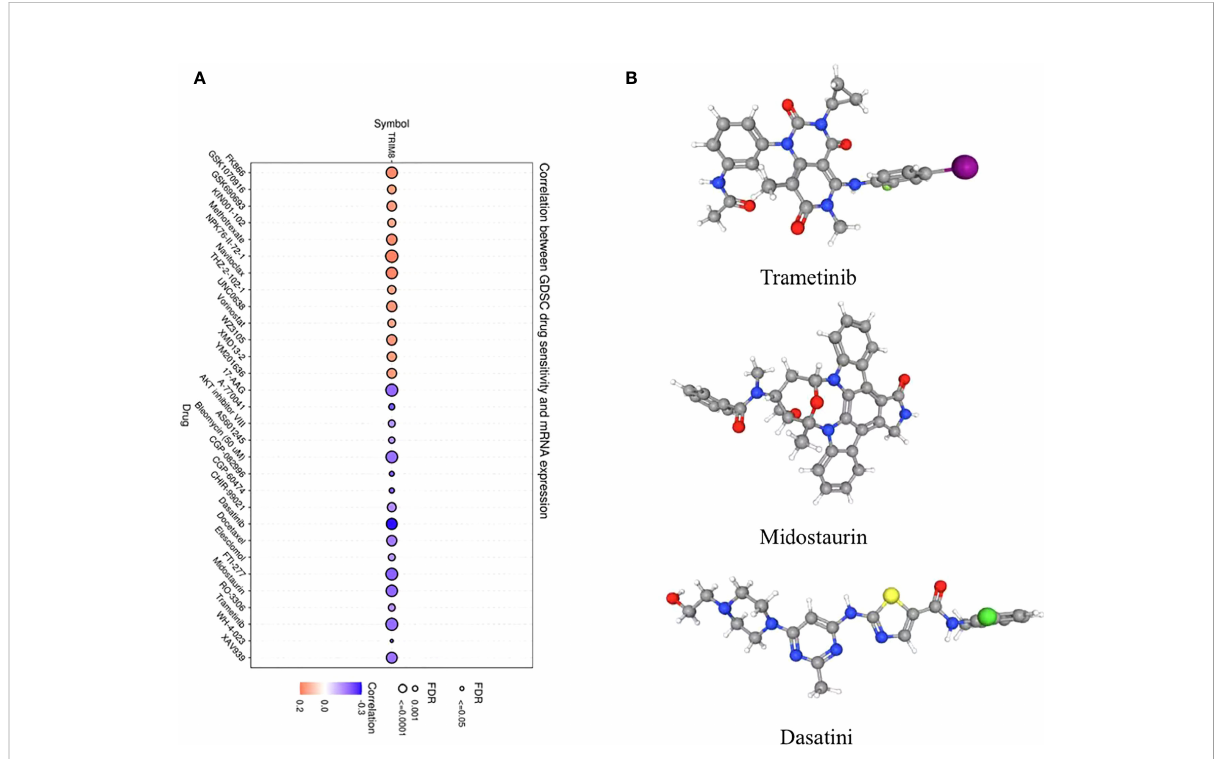
FIGURE 8 Analysis of potential drug sensitivity of TRIM8. (A) The Gene Set Cancer Analysis (GSCA). (B) Structure of potential targeted drugs, including trametinib, midostaurin, and dasatinib.